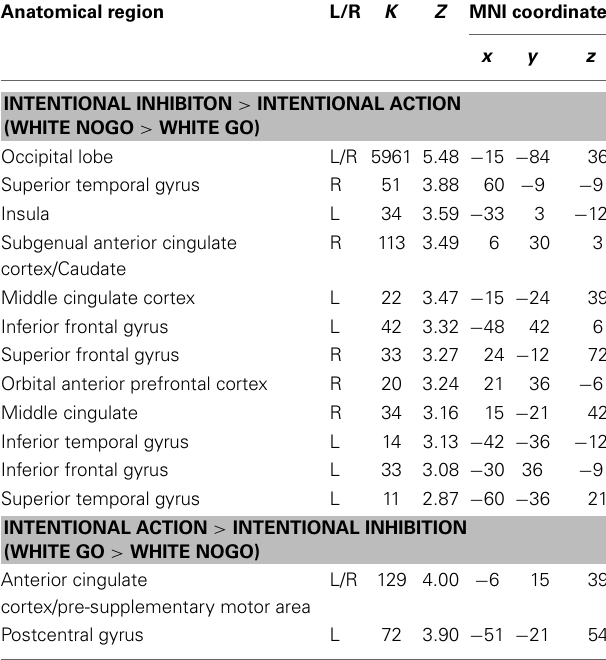
Table 2 | Brain regions revealed by whole brain contrast, focused on decision outcomes (FDR corrected, p < 0 . 05, > 10 voxels, except for White Go > White NoGo which was thresholded p < 0 . 001 uncorrected, > 10